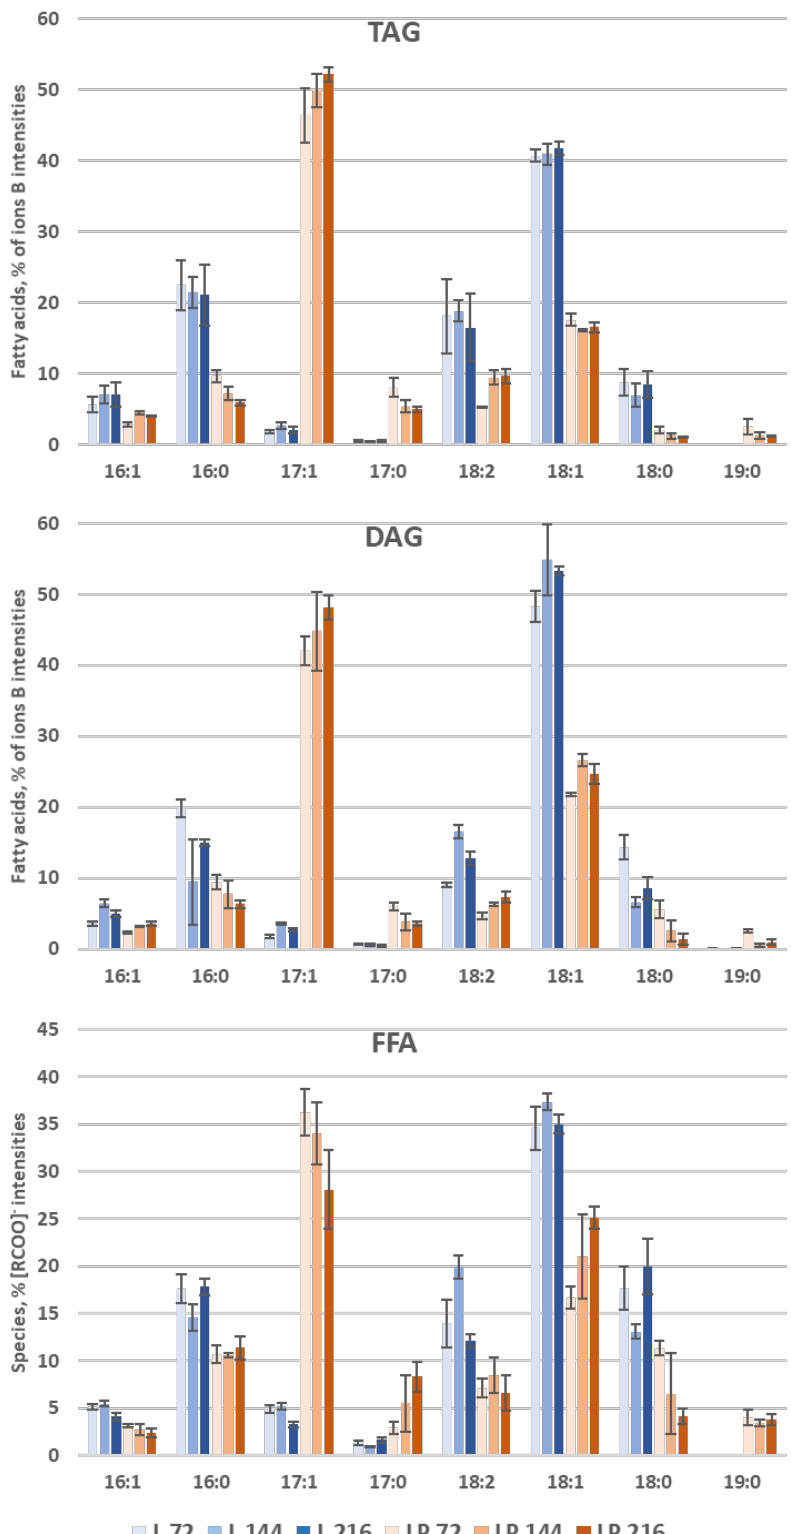
Figure 5. Comparison of the storage lipid composition in the obese L and obese LP over time. Lipid profiles in % FA per classes for TAG and DAG and % [RCOO] − Intensities for FFA. Mean values are displayed ( n = 3, ±SD). Lipid species below 3% are not indicated.